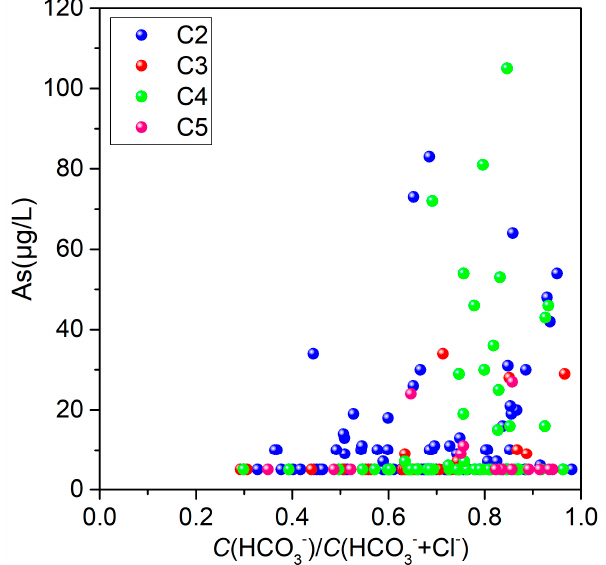
Figure 8. Scatter plot of HCO 3 − /(HCO 3 − +Cl − ) versus As of shallow groundwater in the different zones.